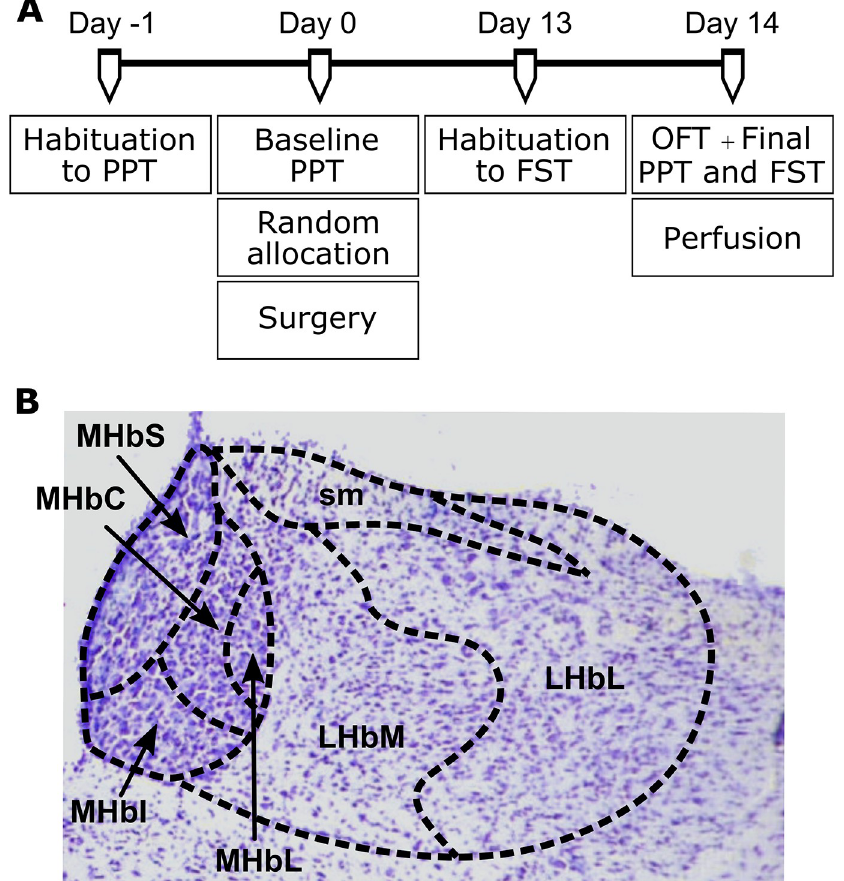
Fig 1. Methods of study. A. Experimental design. After habituation to the animal facility, Wistar rats habituated to the paw pressure test (PPT) and, on the following day, were evaluated for baseline measures of mechanical nociceptive threshold. Animals were then randomly allocated into three groups (i.e. naive [no surgery], false-operated, and chronic constriction injury [active surgery]), followed by the assigned surgery. Thirteen days after the baseline measure, animals were habituated to the Forced Swimming Test (FST). On the following day, animals were tested in the Open Field Test (OFT) and final measures of the PPT and FST were taken. B. Photomicrography of a Nissl-stained coronal slice, showing the lateral and medial habenula and its subdivisions. Abbreviations: LHbL: Lateral subdivision of the lateral habenula. LHbM: Medial subdivision of the lateral habenula. MHbS: Superior subdivision of the medial habenula. MHbI: Inferior subdivision of the medial habenula. MHbL: Lateral subdivision of the medial habenula. MHbC: Central subdivision of the medial habenula. sm: stria